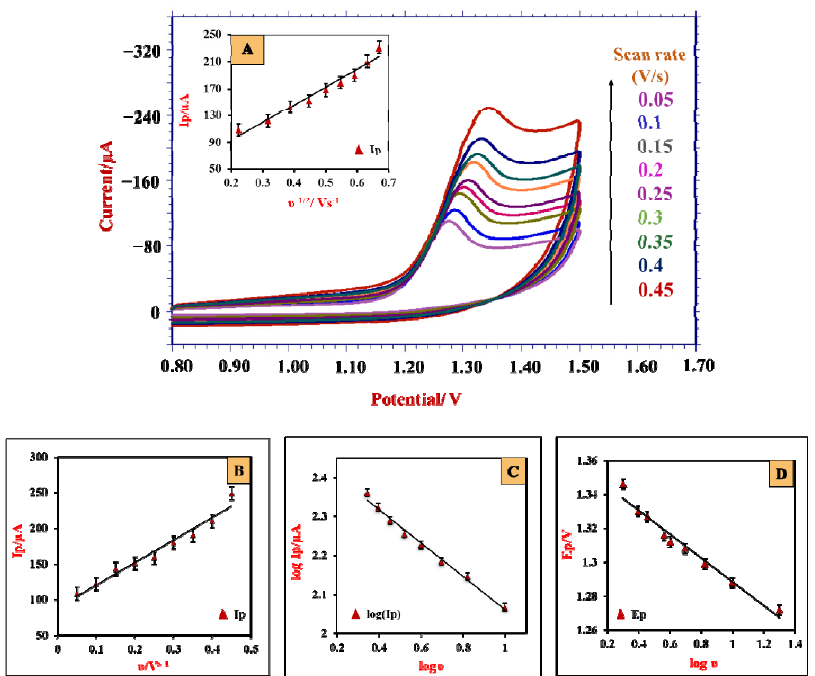
Figure 5. Cyclic voltammograms for 0.1 mM CIP in pH 4.2 at varied scan rates ranging from 0.05 to 0.45 Vs − 1 . ( A ) plot of I p vs. υ 1/2 , ( B ) plot of I p vs. υ , ( C ) plot of logI p vs. log υ , and ( D ) plot of Ep vs. log υ .